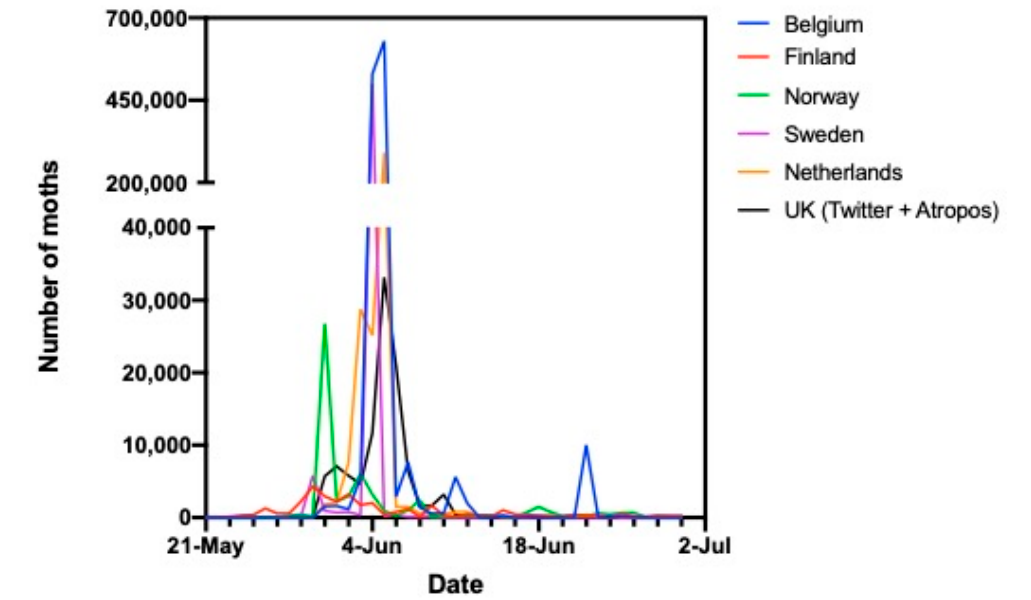
Figure 4. Comparison of peaks in abundance of P. xylostella in different European countries in 2016 (using numbers of moths seen per day by citizen scientists in each country).